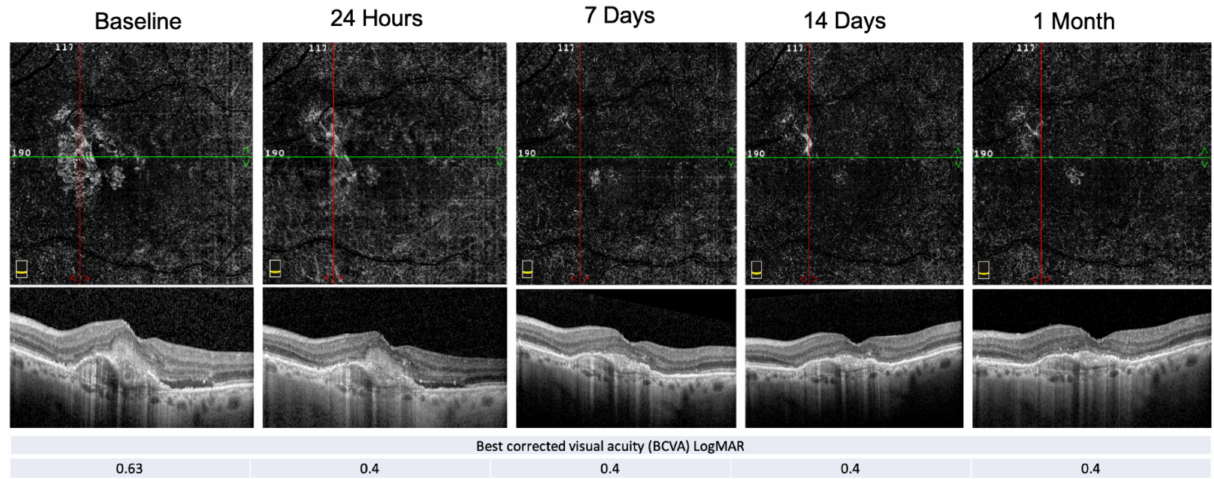
Figure 4. E-AMD morpho-functional assessment by structural OCT, OCT-A and BCVA. Structural OCT shows the reabsorp- tion of the subretinal hyper-reflective material (SHRM) and the resolution of the subretinal fluid at the end of the follow-up period. PED-HMDs did not significantly change during the visits, whereas the PED-MH did. The red and green line show respectively the vertical and horizontal scan